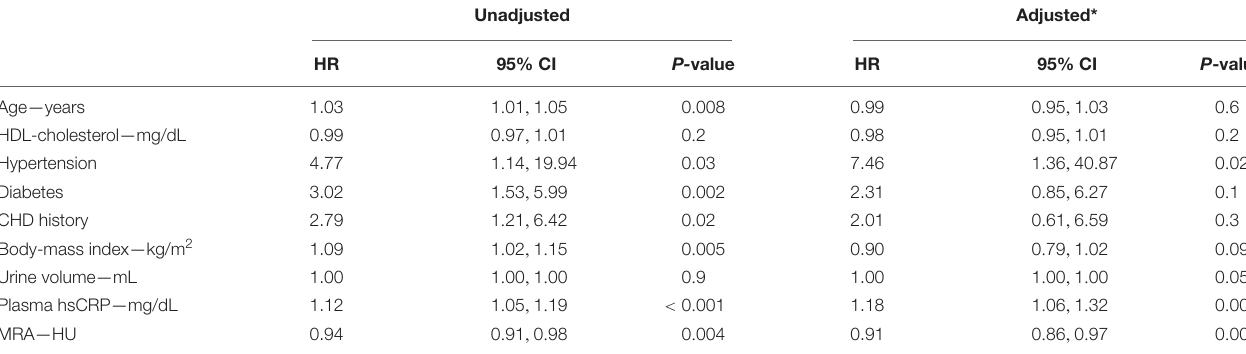
TABLE 2 | Cox proportional hazard ratios for the time to first CVD event based on traditional risk factors and MRA at dialysis start. Unadjusted Adjusted* HR 95% CI P- value HR 95% CI P